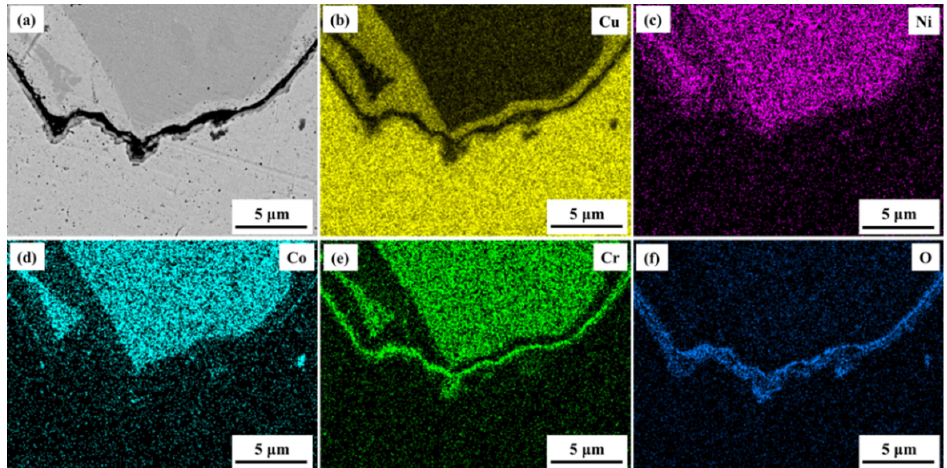
Figure 6. Interfacial morphology and elemental distributions at the interface of the Cu substrate and Cu35Ni25Co25Cr15 HEA coating deposited under a welding current of 130 A: ( a ) interfacial morphology; ( b – f ) distributions of Cu, Ni, Co, Cr, and O, respectively.